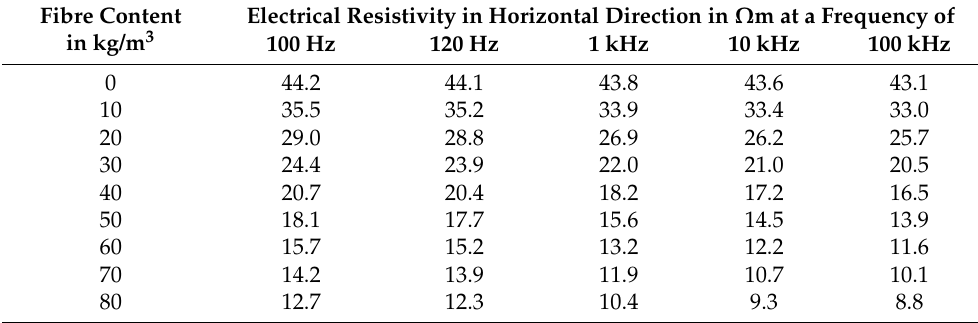
Table A23. Results of the resistivity measurements of the concrete mixture 32-60-300-00-F3. Fibre Content